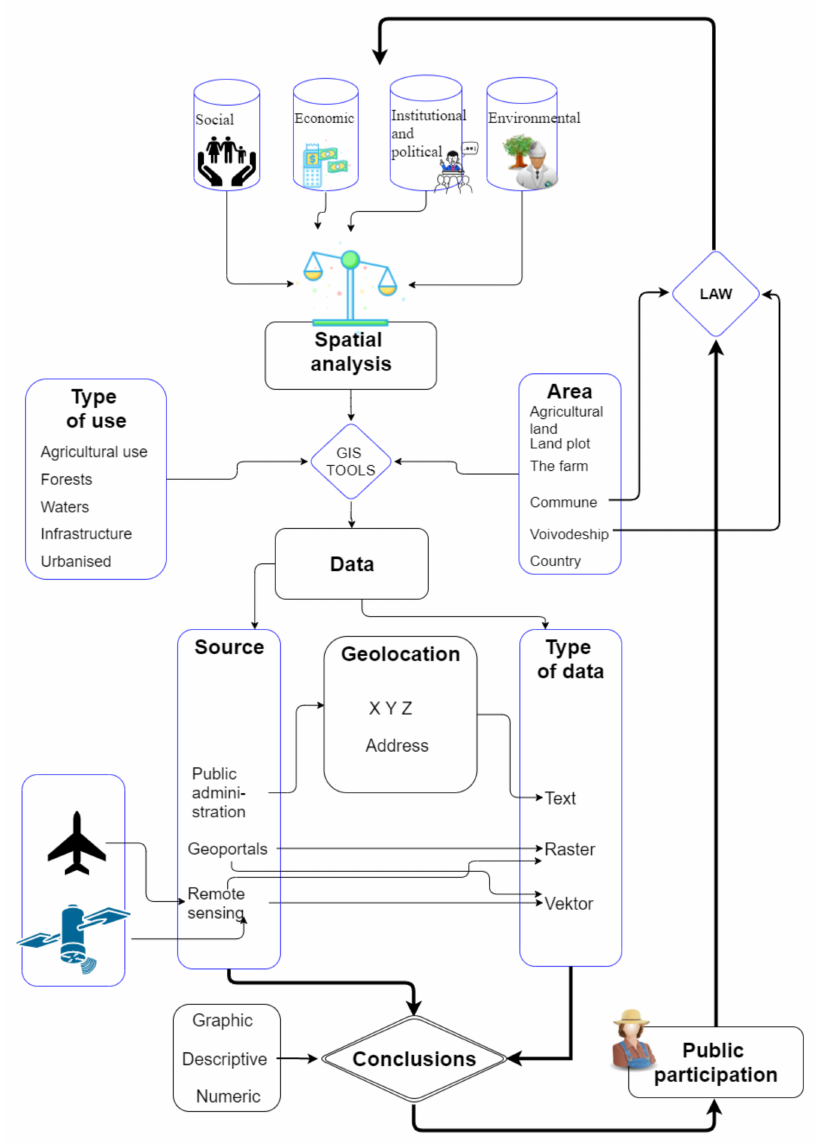
Figure 1. The scope, sources, and applicability of data for spatial analyses. Source: own